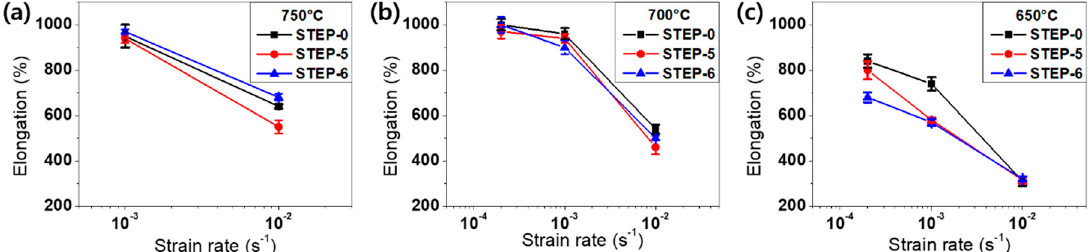
Figure 5. Variation of EL depending on the strain rate for the investigated alloys at ( a ) 750 ° C, ( b ) 700 ° C, and ( c ) 650 ° C. and ( c ) 650 ◦